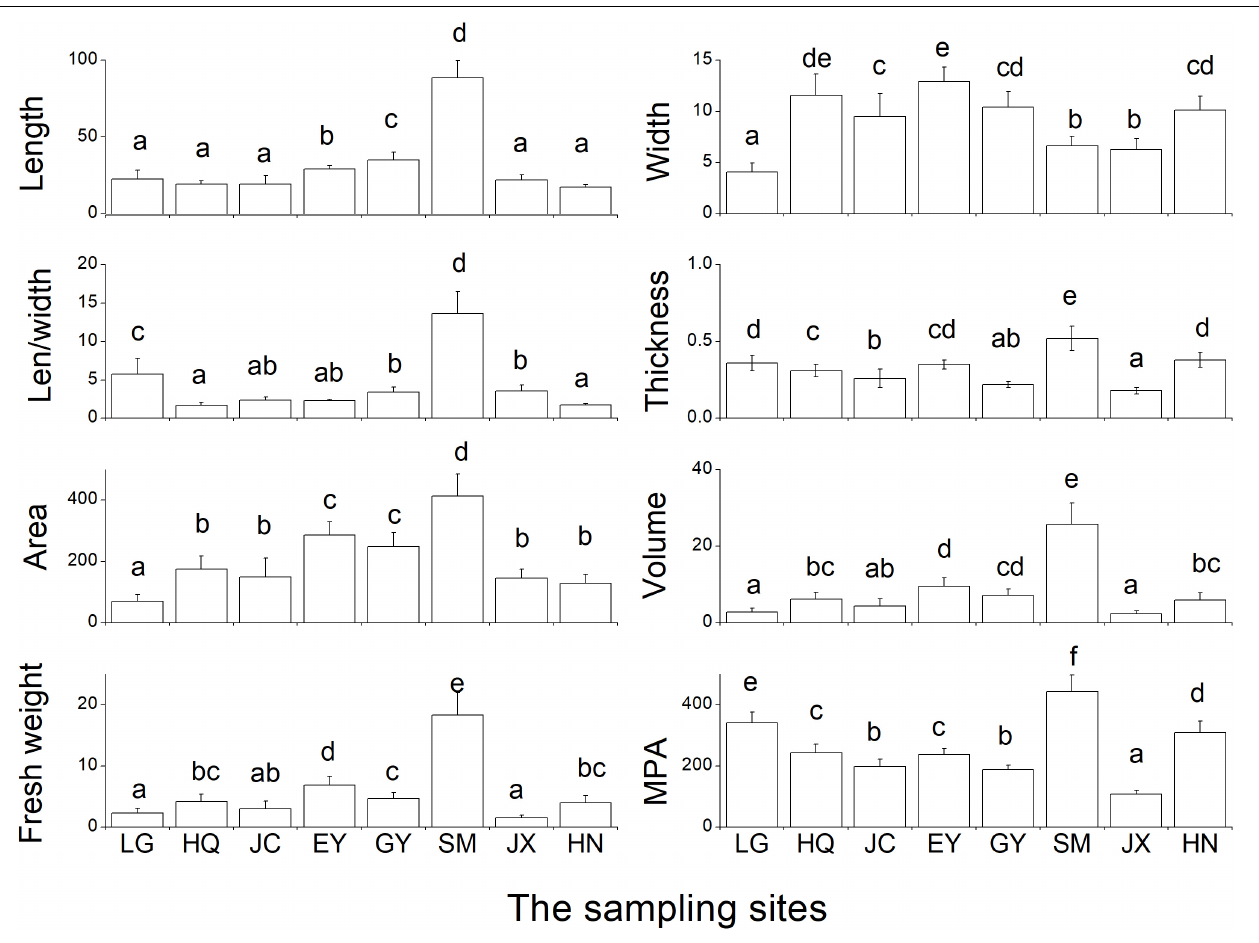
FIGURE 6 | The eight leaf traits of morphology and biomass in the eight populations. Len/width refers to the ratio of leaf length and leaf width. MPA refers to the biomass per area of the determined leaf (unit: g m − 2 ). Leaf length and width is with the unit of cm, thickness with the unit of mm, area with the unit of cm 2 , and volume with the unit of cm 3 , fresh weight with the unit of g. The different letters in the figure indicate the significant difference among the eight population. TABLE 5 | The Pearson correlation between eight leaf traits of morphology and biomass in the eight populations. Width Len/width Area Thickness Volume